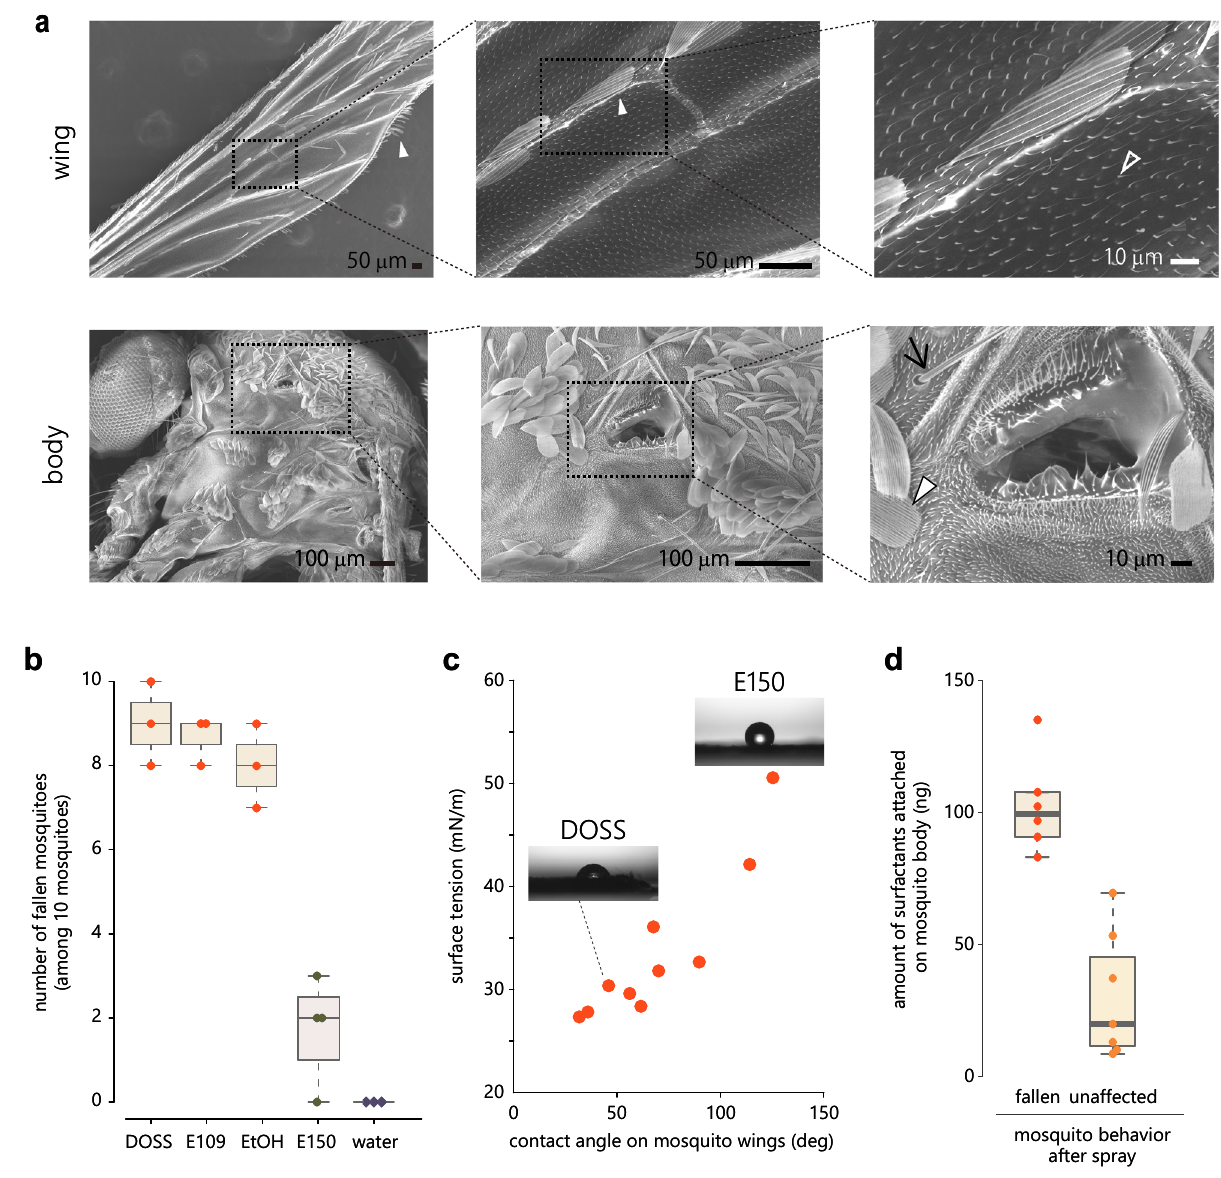
Figure 1. Solution with low surface tension can wet mosquitoes and make them fall. ( a ) SEM image of a surface of mosquito’s wings (top) and body (bottom). Mosquito body and wings were covered with scale (filled arrowhead), micro cilia (open arrowhead) and cilia (arrow). ( b ) The effect of each sprayed solution on mosquitoes staying on the wall. The number of mosquitoes (out of 10) that fell from the wall after spraying 3 mM DOSS, 3 mM E109, 70% EtOH, 3 mM E150, and pure water. ( c ) Correlation between the contact angle on mosquito wings and surface tension of surfactant solution. Droplets of E150 and DOSS on mosquito wings are shown in the pictures. Each dot indicates a surfactant. The surfactants used are DOSS, lauroylaminopropyldimethylamine oxide, alkyl benzyl dimethyl ammonium chlorides, polyoxyethylene (5) lauryl ether, polyoxyethylene (6) lauryl ether, E109, polyoxyethylene (12) lauryl ether, polyoxyethylene (19) lauryl ether, E150 and lauryl glucoside. The concentration for all the surfactant solutions is 3 mM. ( d ) The amount of DOSS attached on the body of fallen (n = 6) and unaffected mosquitoes (n = 7) after spraying 2 mM